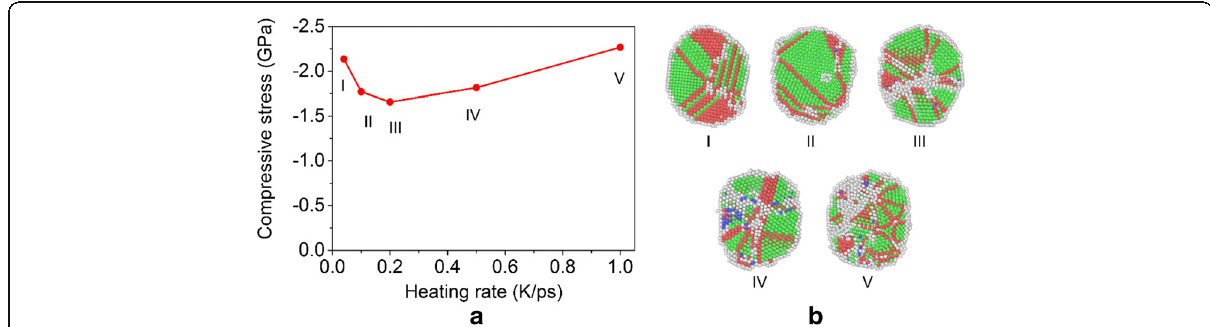
Fig. 10 Influence of the heating rate on the mechanical properties of sintered nanoparticles. a Final compressive stress as a function of heating rate for the sintered particles without considering the system vibration. b Corresponding nanostructures of the sintered nanoparticles under different heating rates